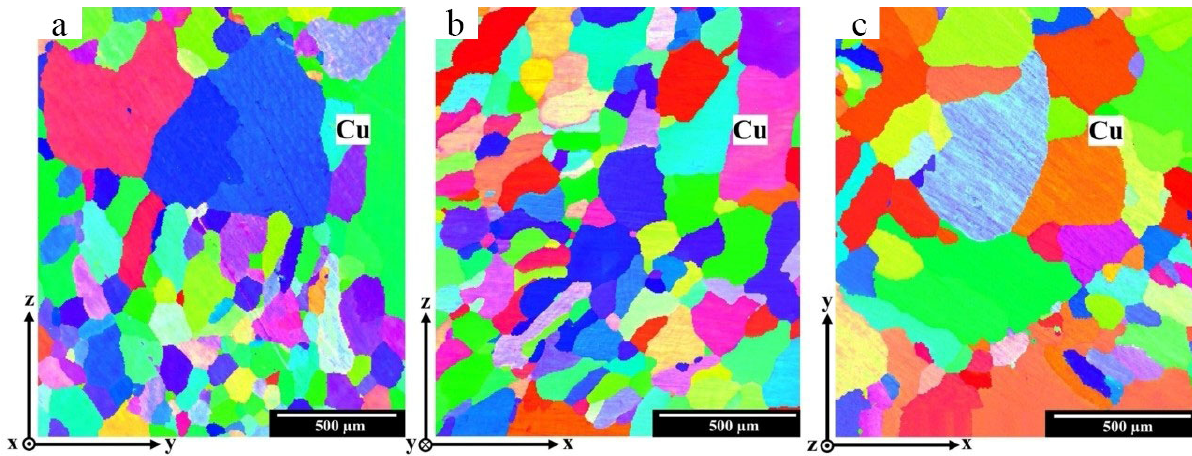
Figure 9. IPF maps of upper layers of Cu at ( a ) y ‐ z, ( b ) x ‐ z, and ( c ) x ‐ y planes [109]. These variations result in heterogeneous microstructures and properties in different areas of the part. At each location on the part, the microstructure and grain structure of the alloy that is formed after the first thermal cycle is often altered by subsequent thermal cycles. The temperature gradient plays a key role in the morphology and size of the struc ‐ ture and determines the crystallization mode. When the first layers of M1 copper are de ‐ posited on a 321 stainless steel substrate, rapid heat dissipation occurs, which entails the formation of a fine ‐ grained structure. As the workpiece grows, the influence of these fac ‐ tors decreases and directional grain growth occurs. Directed grain growth is facilitated by the slow heat dissipation and temperature gradient formed in the additive billet growth